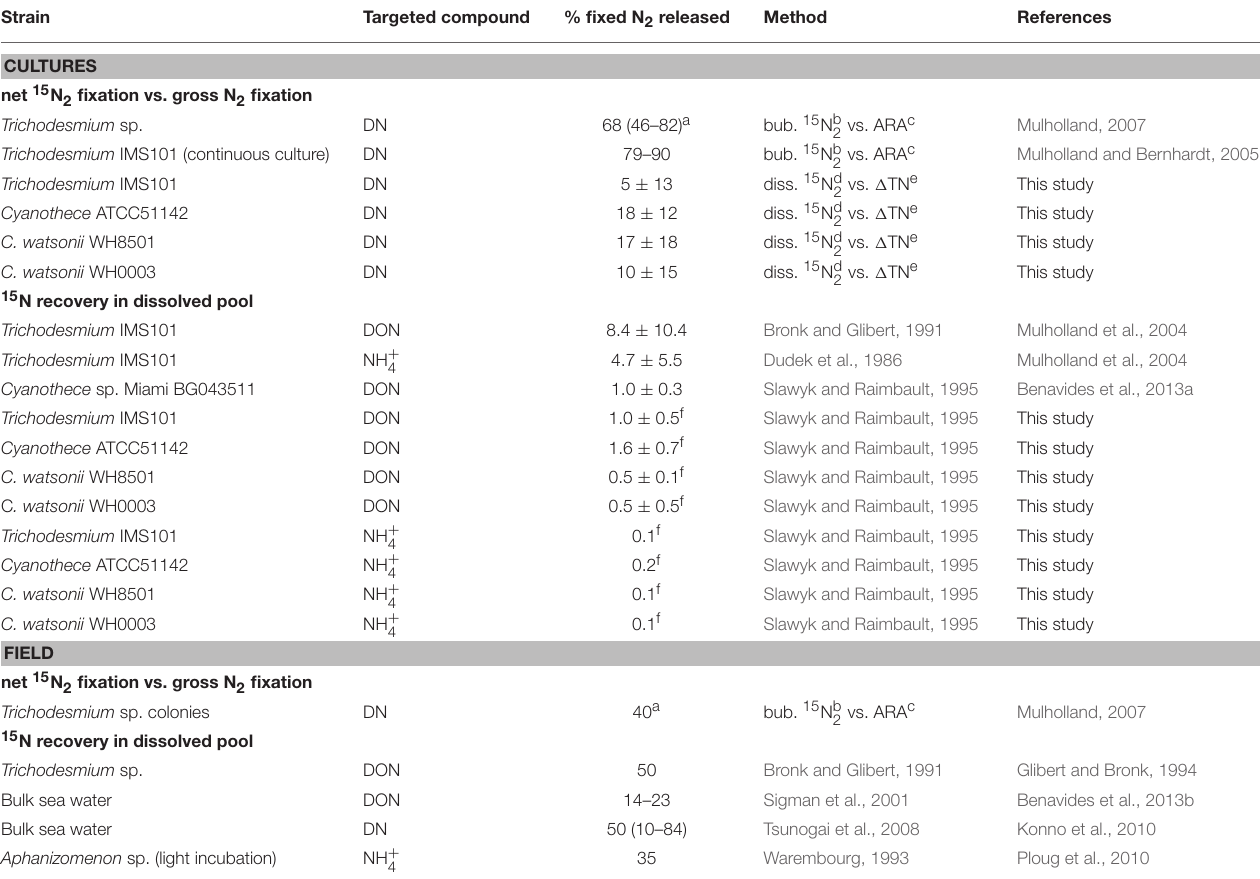
TABLE 1 | Summary of the fixed N 2 released as DN, NH + 4 , or DON reported for diazotrophs in the literature and in this study (in percentage of the gross N 2 fixation) as a function of the methodology